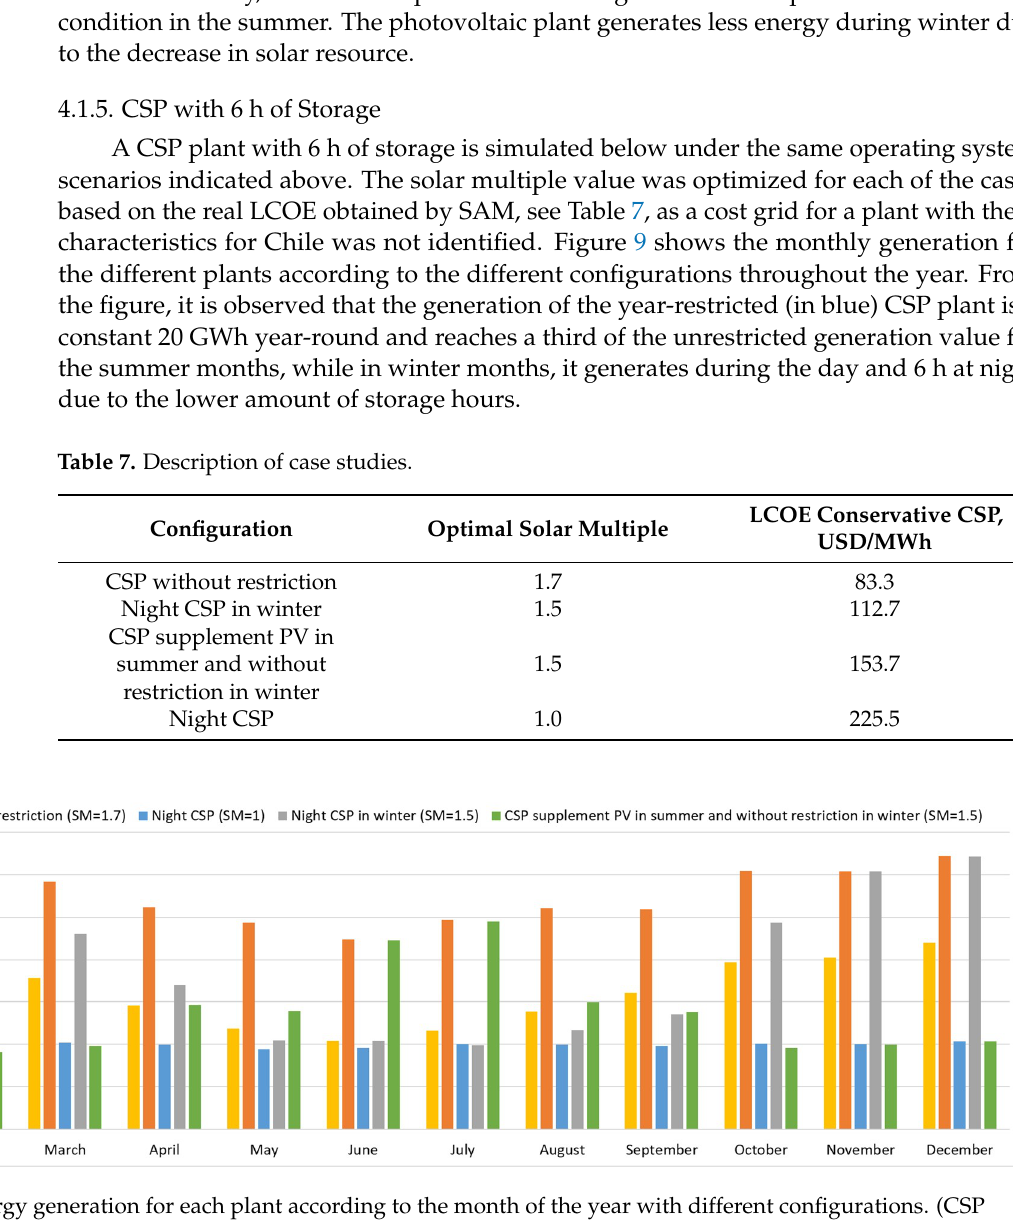
Table 8. Technical parameters for the economic evaluation of the hybrid plant.